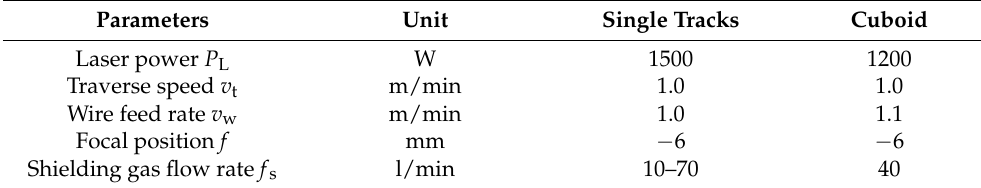
Table 3. Process parameters for the deposition of individual weld beads and a cuboid. Parameters Unit Single Tracks Cuboid Laser power P L W 1500 1200 Traverse speed v t m/min 1.0 1.0 Wire feed rate v w m/min 1.0 1.1 Focal position f mm − 6 − 6 Shielding gas flow rate f s l/min 10–70